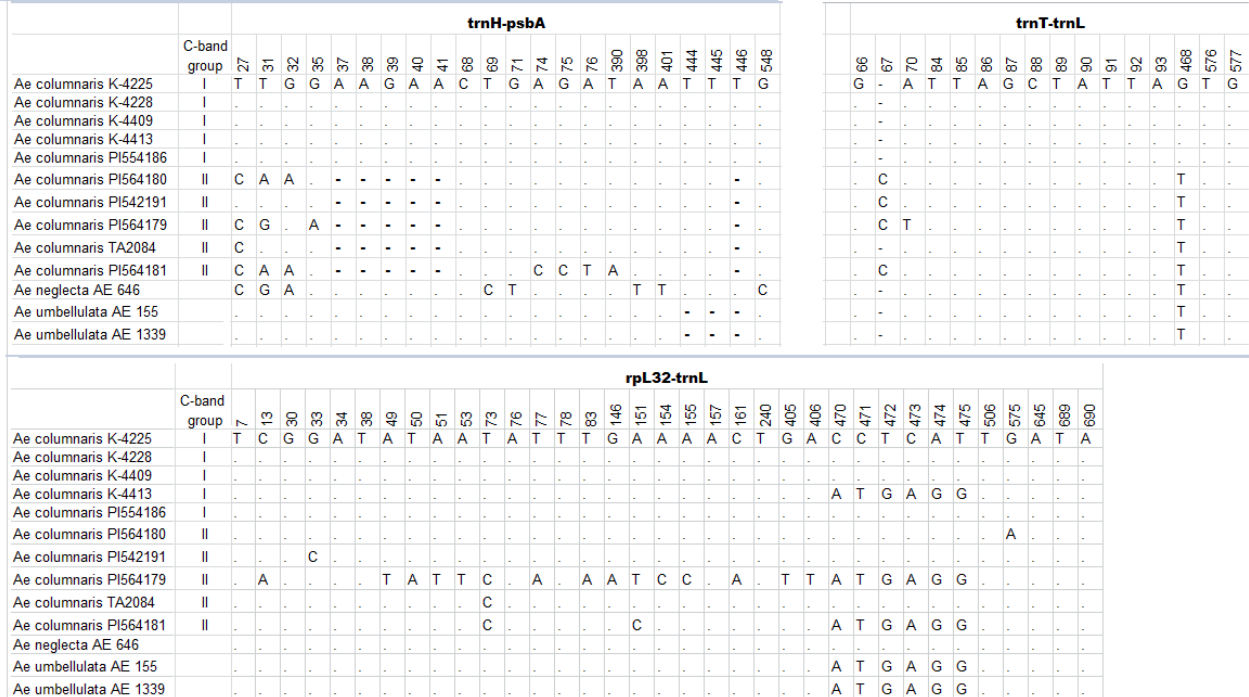
Figure 12. Nucleotide substitutions in trnH-psbA , trnT-trnL , rpL32-trnL plastome regions in 13 Ae. columnaris (U c U c X c X c ), Ae. neglecta (U t U t X t X t ), and Ae. umbellulata (UU) sequences. Dots correspond to nucleotides identical to consensus sequences.